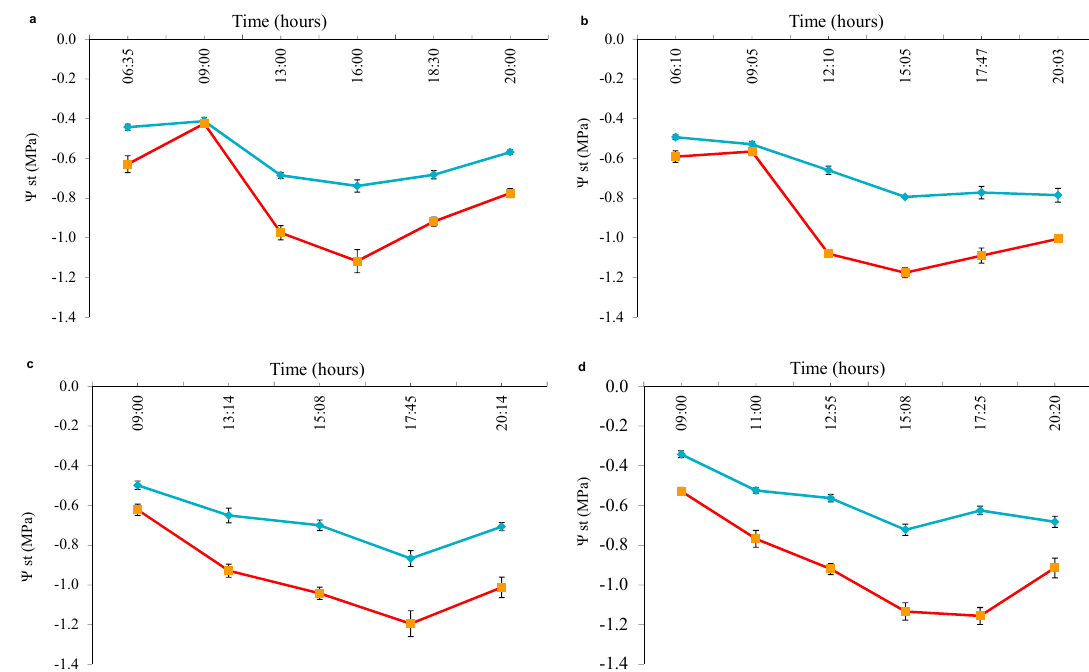
Figure 3. Plum s tem water potential along the day in the control (C, ∆ ) and stressed plots (DI, □ ) for four dates: ( a ) 1 July; ( b ) 8 July; ( c ) 14 July; ( d ) 22 July. Each point represents the average of 8 trees; the vertical bars represent the standard error of each mean. Hours are legal time (solar time = legal time − 2.7 h). Plum orchard (Badajoz, Spain).